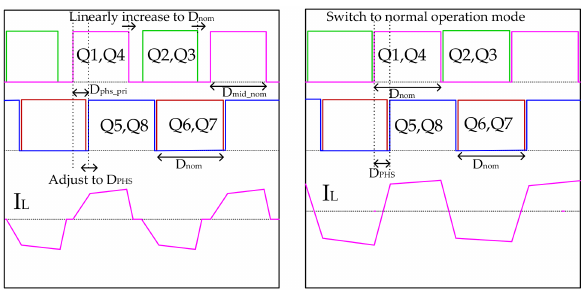
Figure 9. PWM signals plot at phase E soft-start mode.